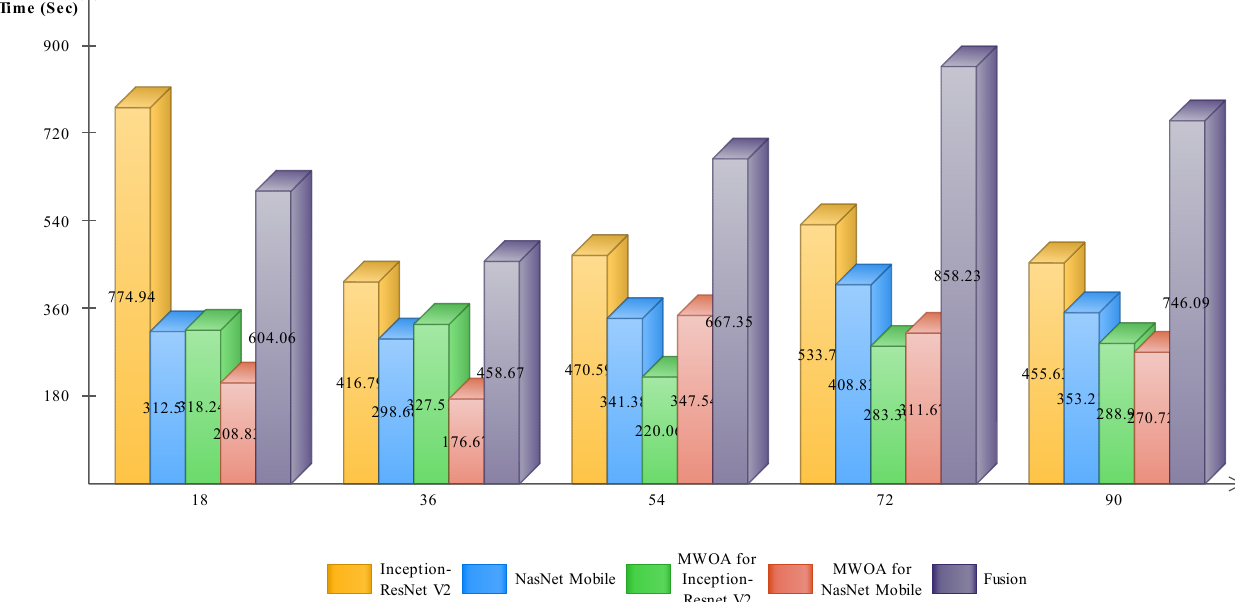
Figure 8. Computational time of Cubic SVM for all five steps.